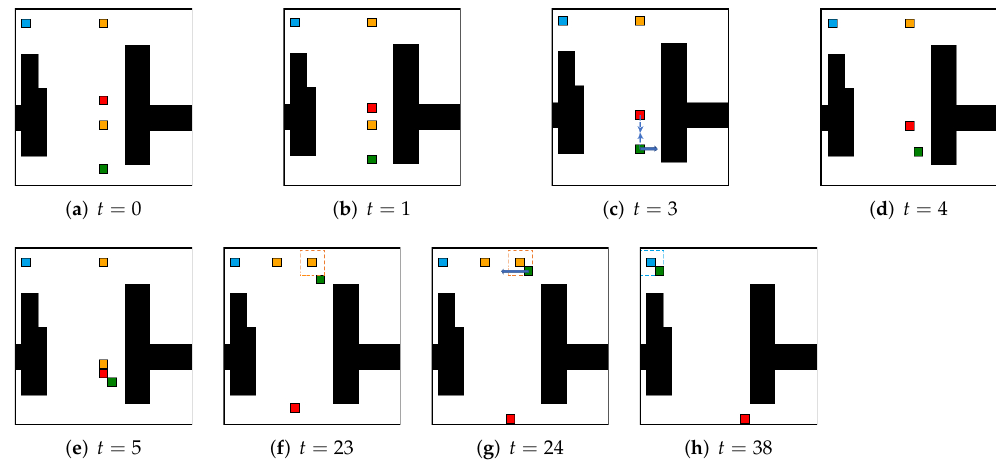
Figure 11. The trajectory of the agent under the condition of k 1 = 1, k 2 = 0 set in f . When k 1 = 1, k 2 = 0, the agent will ignore the risk of collisions while moving.